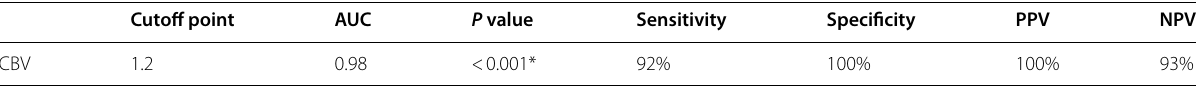
*indicates statistically significant